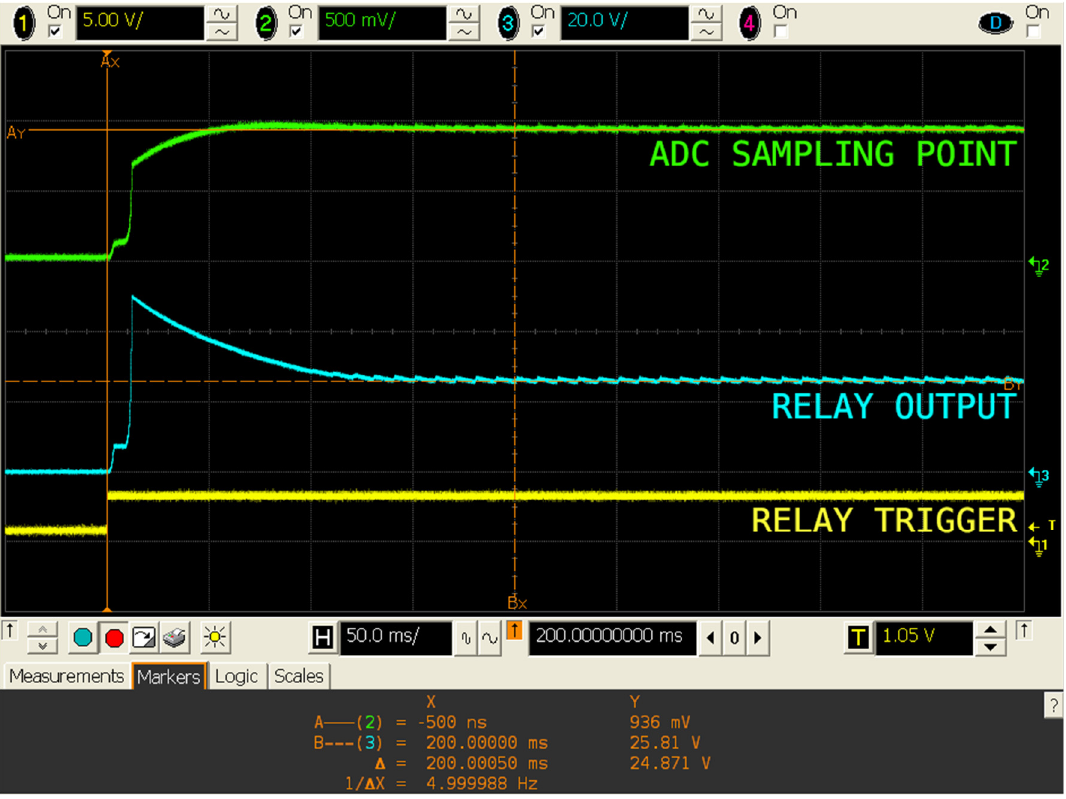
Figure 8. Oscilloscope screenshot: 200 ms convergence time for the metering system.